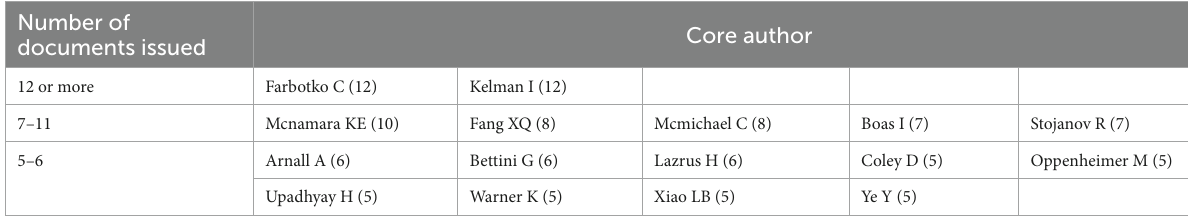
TABLE 3 Statistics of more than five core authors (WOS 2008–2021).